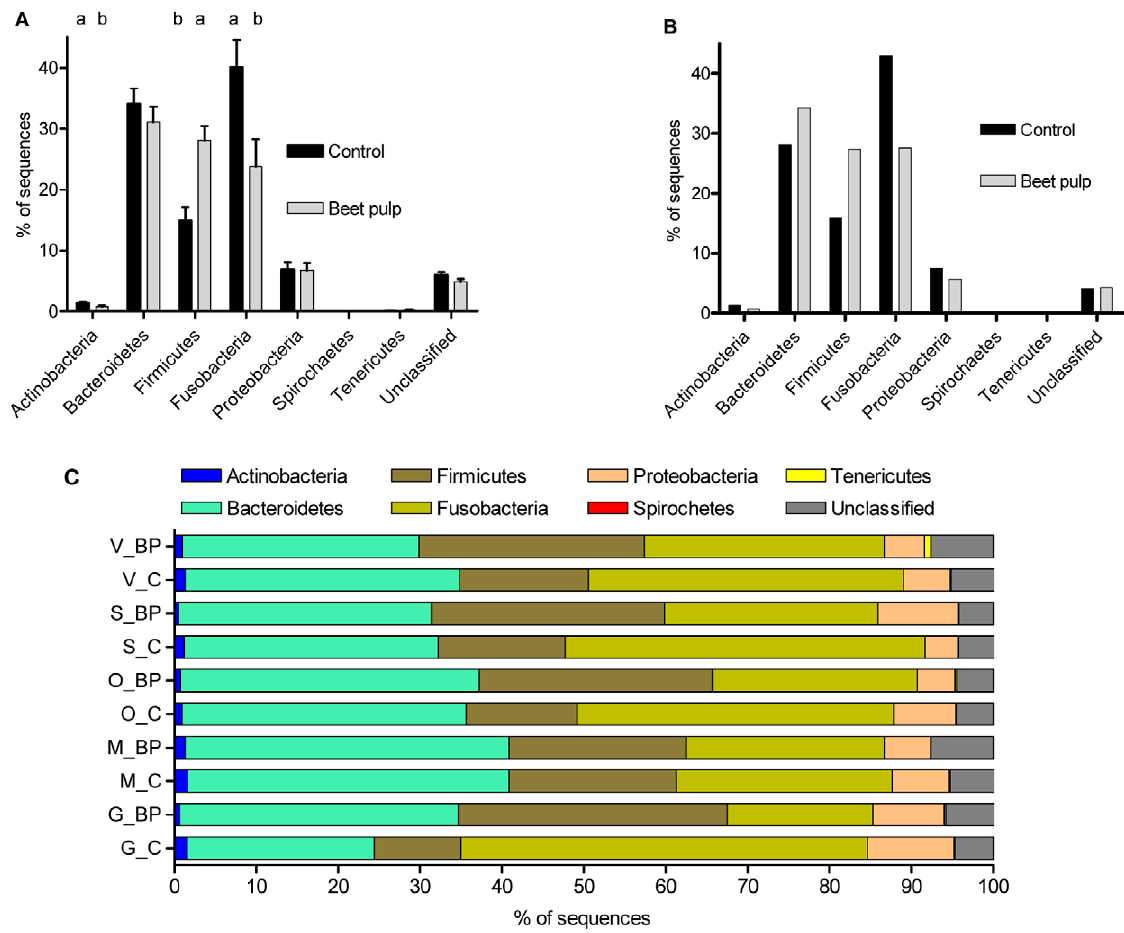
Figure 2. Phylum assignment of V3 16S sequences from dogs fed diets with or without supplemental fiber. Assignment according to the Ribosomal Database Project classifier (v10.2; $ 80% confidence). ( A ) Means of all individual fecal DNA samples. ab Columns within phylum not sharing letters are different (P , 0.05). ( B ) Observed values for single fecal DNA samples pooled by diet. ( C ) Phylum assignment of V3 16S sequences from fecal samples from individual dogs fed diets with (BP) and without (C) supplemental fiber, according to the Ribosomal Database Project classifier (v10.2; $ 80% confidence). The changes that occur in individual animals may be lost when DNA samples are pooled, or when population means are calculated.